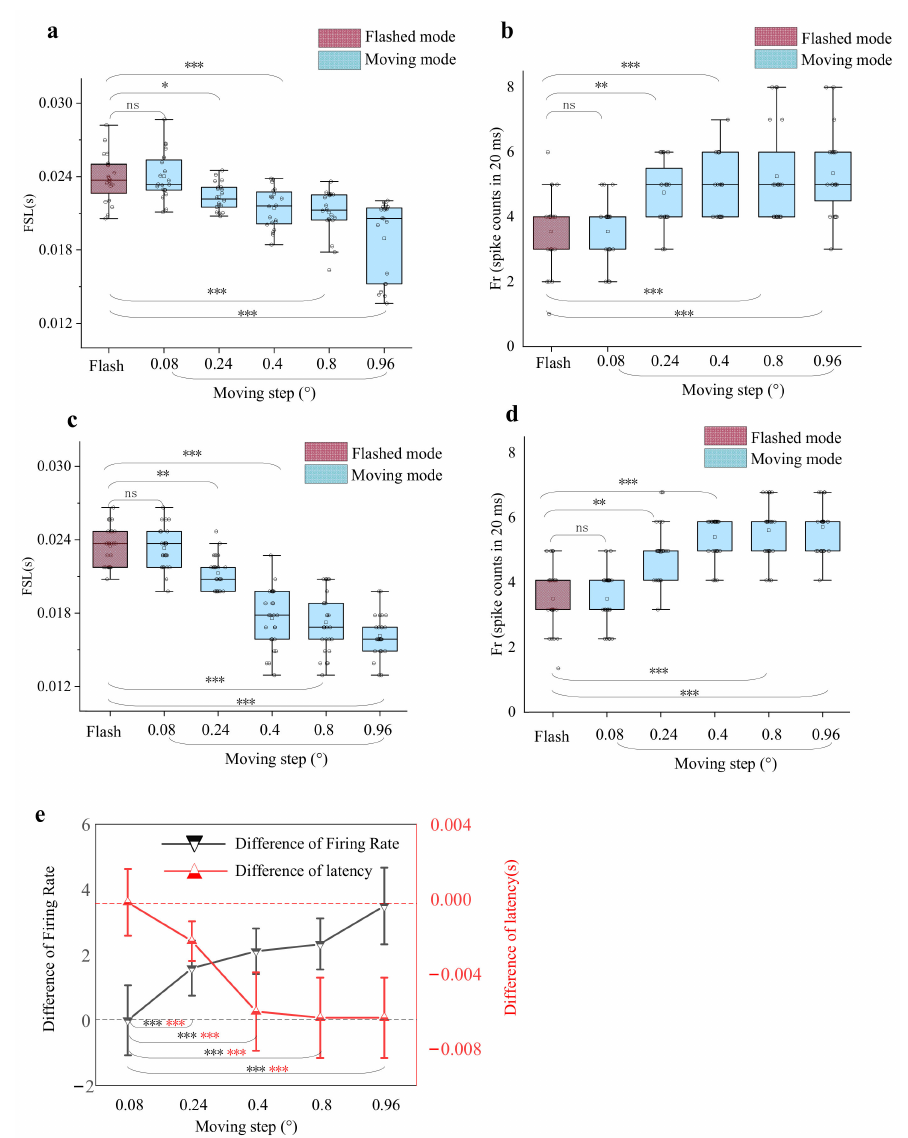
Figure 7. The results for varied moving steps. ( a , b ) The statistical results of the first spike latency and firing rates derived from different moving step length stimuli and flashed square stimuli for 20 repeats. The horizontal line indicates the median of each group of data and the whiskers indicate the lowest and highest point within 1.5 × the interquartile ranges of the lower or upper quartile, respectively. The ‘ns’ indicates no significant difference between two groups of data (Bonferroni corrected, Wilcoxon rank-sum test, p > 0.05), ‘*’ indicates a weak difference between two groups of data (Bonferroni corrected, Wilcoxon rank-sum test, 0.01 < p < 0.05), ‘**’ indicates a little difference between two groups of data (Bonferroni corrected, Wilcoxon rank-sum test, 0.001 < p < 0.01) and ‘***’ indicates a significant difference between two groups of data (Bonferroni corrected, Wilcoxon rank-sum test, p < 0.001) ( c , d ). The boxplot graphs for statistical first spike latency and firing rates results of 27 recording units. Error bars as in ( a , b ). ( e ) The mean difference between Fr and FSL (flash latency minus motion latency) varied moving steps. All data represent mean (triangular symbols) and standard error (error bars), and dotted reference lines represent zero. Red asterisks indicate the levels of significance obtained from the mean difference in FSL. Black asterisks indicate the levels of significance obtained from mean difference in